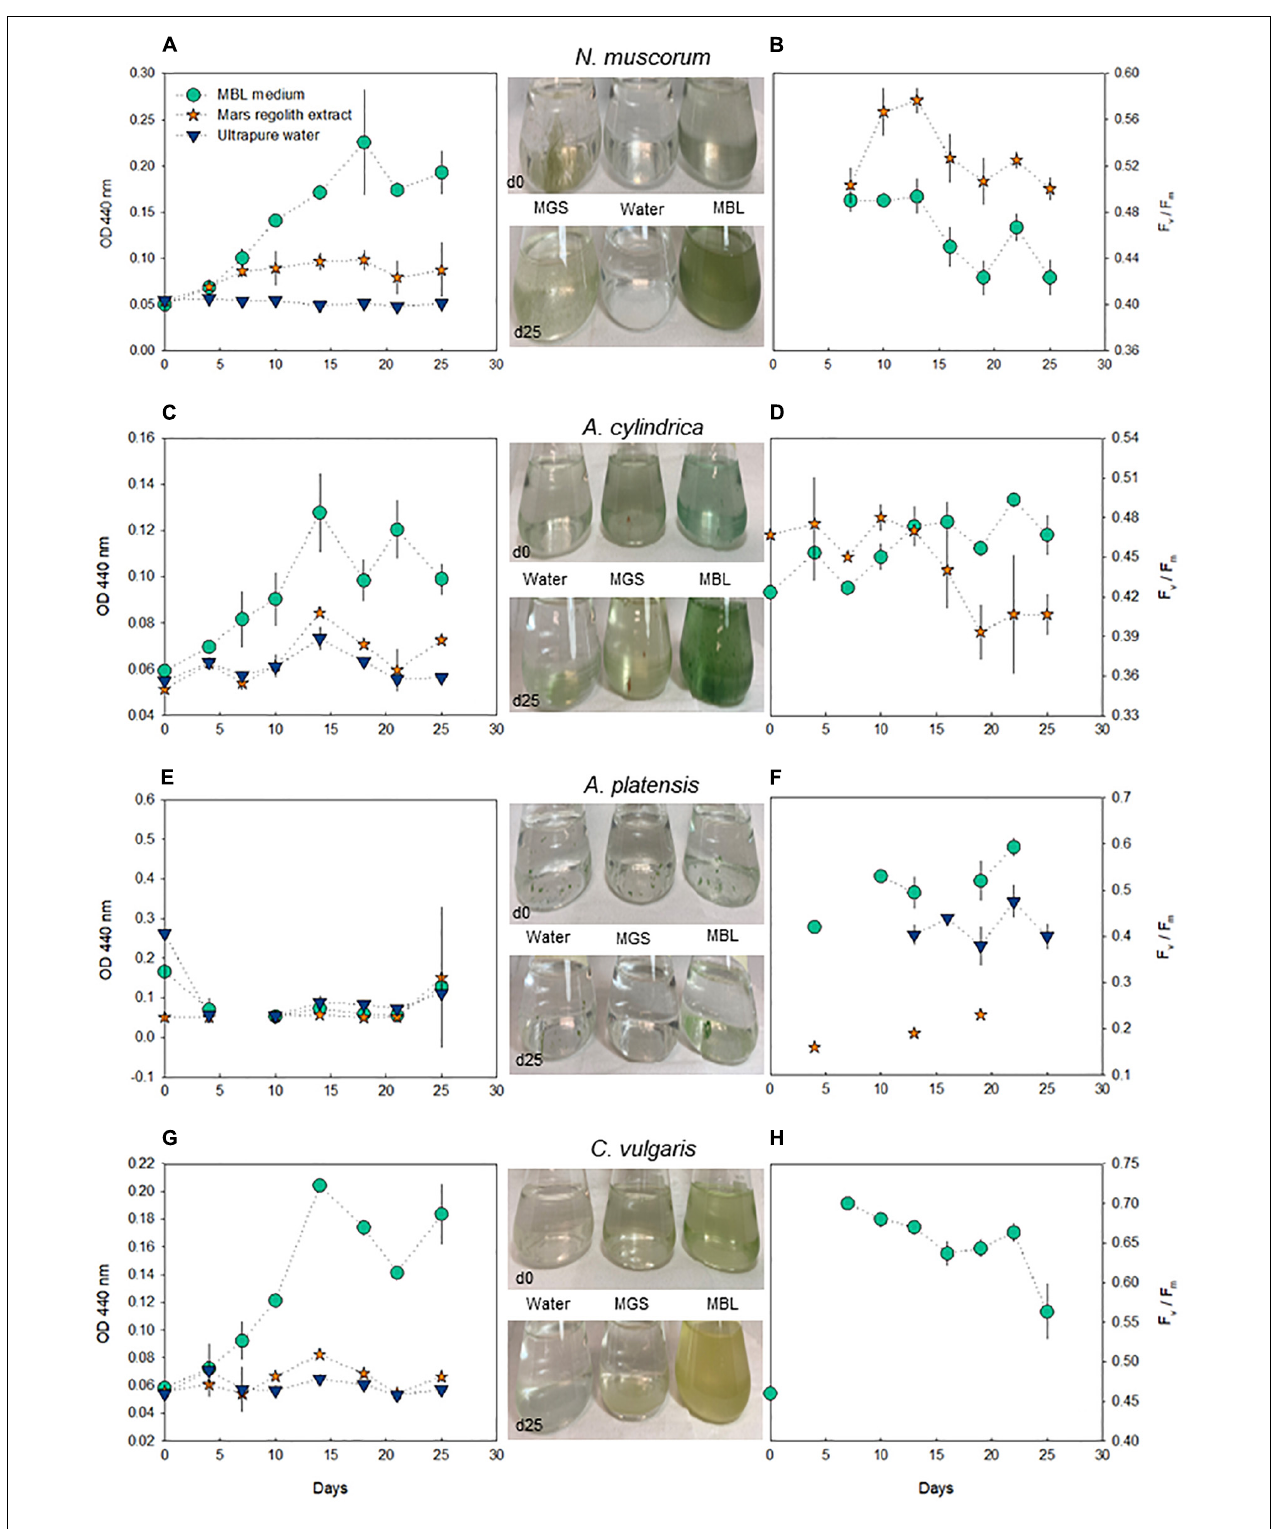
FIGURE 1 | Profiling of N. muscorum , A. cylindrica , A. platensis , and C. vulgaris throughout a monitoring period of 25 days, regarding OD measurements at 440 nm (A,C,E,G) and PS II efficiency (F v /F m ) (B,D,F,H) (only data with F 0 > 100 are depicted). Marks represent the mean values and the error bars represent the standard deviation ( n = 3). In the central panel, illustrative photos are provided (full documentation in Supplementary Figure 1 ).